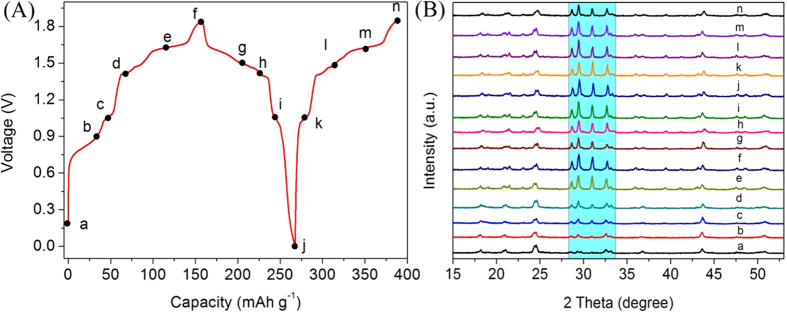
(A) The first two charge-discharge curves of
LiTi2(PO4)3@C//LiMn2O4
ARLB at 30 mA g−1. (B) XRD
patterns of LiTi2(PO4)3@C at
different cell voltages: a - 0 V, b - 0.9 V, c -
1.0 V, d - 1.4 V, e - 1.6 V, f -
1.85 V, g - 1.5 V, h - 1.4 V, i -
1.05 V, j - 0 V, k - 1.05 V, l -
1.5 V, m - 1.6 V and n - 1.85 V at
30 mA g−1.